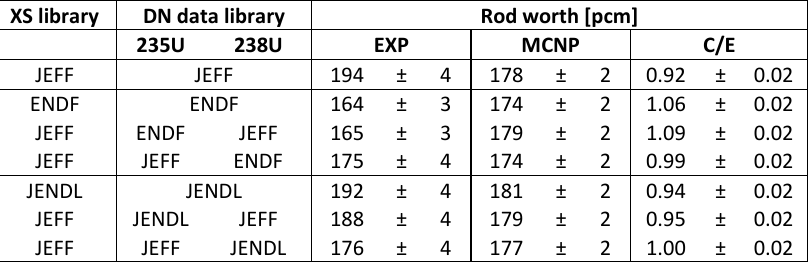
Table 4. Comparison of the experimental and calculated rod worth when JEFF-3.1.2, JENDL-4.0 and ENDF/B-VII.1 libraries are utilized for experimental data analysis (eq. (1)) as well as for the MCNP